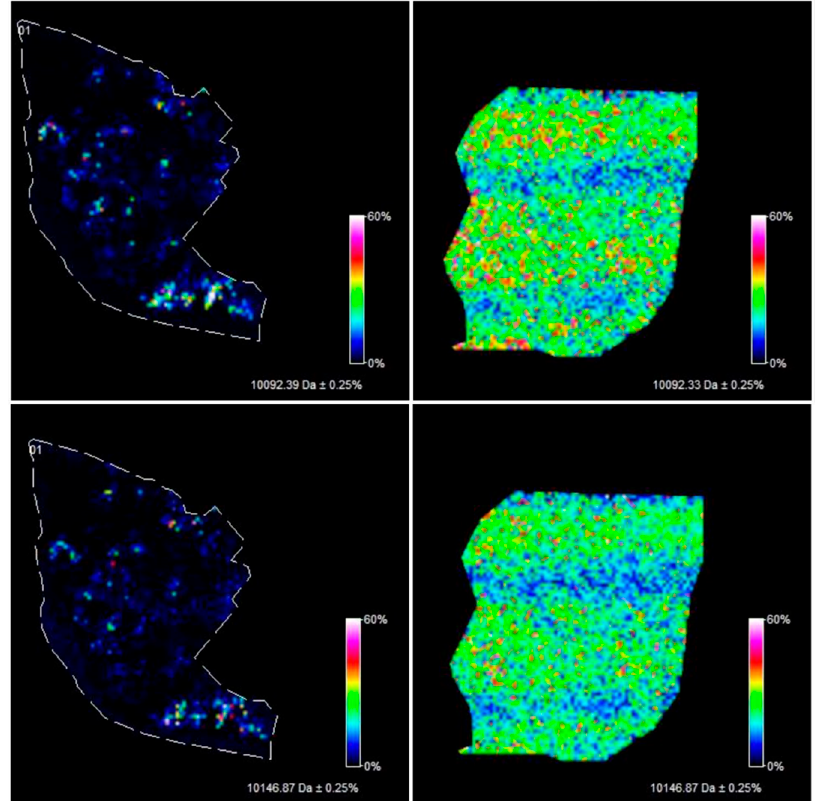
Figure 4. Visualization of the peaks (m/z: 6204.735, 8453.171, 10,146.87, 10,092.39) differentiating the borderline ovarian tissue ( left ) from the ovarian fibrothecoma tissue ( right ) based on the average spectra.